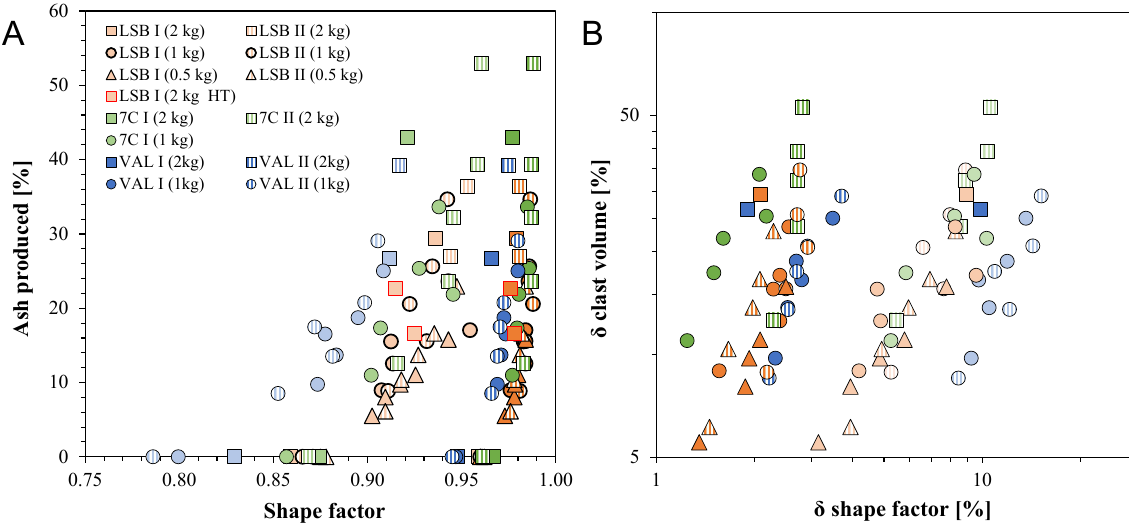
Figure 8: Solidity (dark colours) and form factor (pale colours) evolution with ash production. [A] A similar curve is observed for ash production and shape evolution during tumbling for all materials and starting masses, with VAL clasts o ff set to less circular and convex shapes than the pumice samples. Consistent variation between type I and type II experiments is not evident. [B] Fractional volume loss is equivalent to fractional ash production in a closed system; ash production shows a power law trend with change in solidity or form factor from an initial value. The key in [A] applies to both